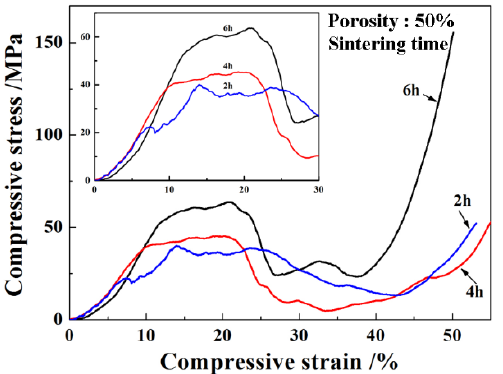
Figure 8. Effect of sintering time on the compressive stress-strain curves for porous Mo deposits with 50% porosity.